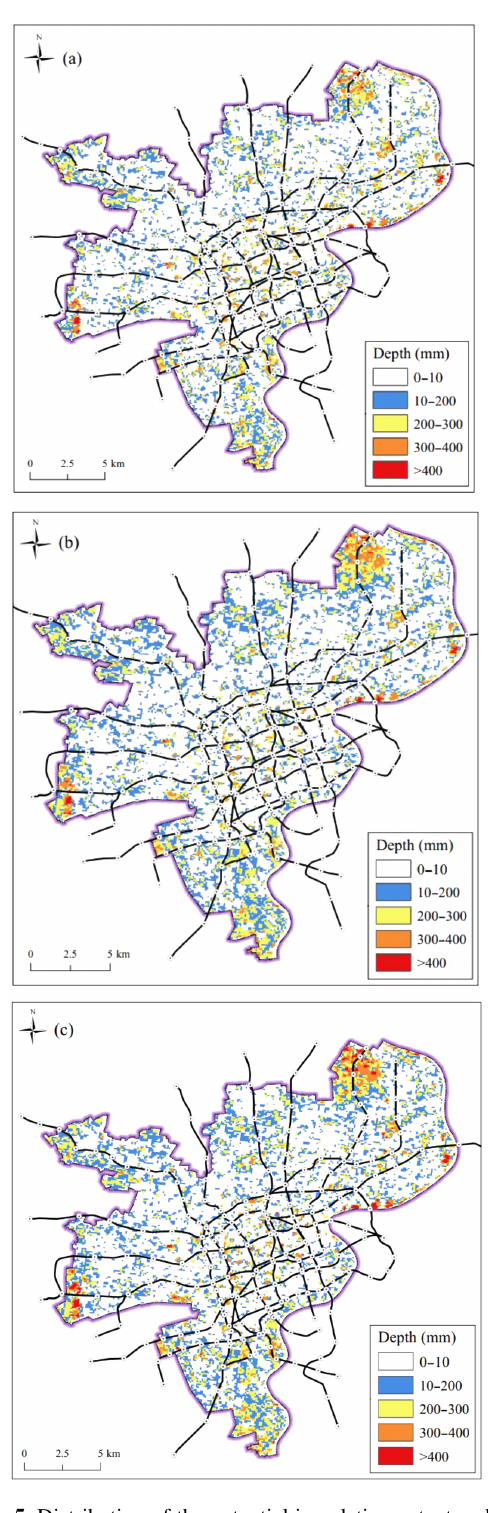
Figure 5. Distribution of the potential inundation extent and depth under different rainfall intensities: (a) 50-year, (b) 100-year, and (c) 500-year rainfall intensity.